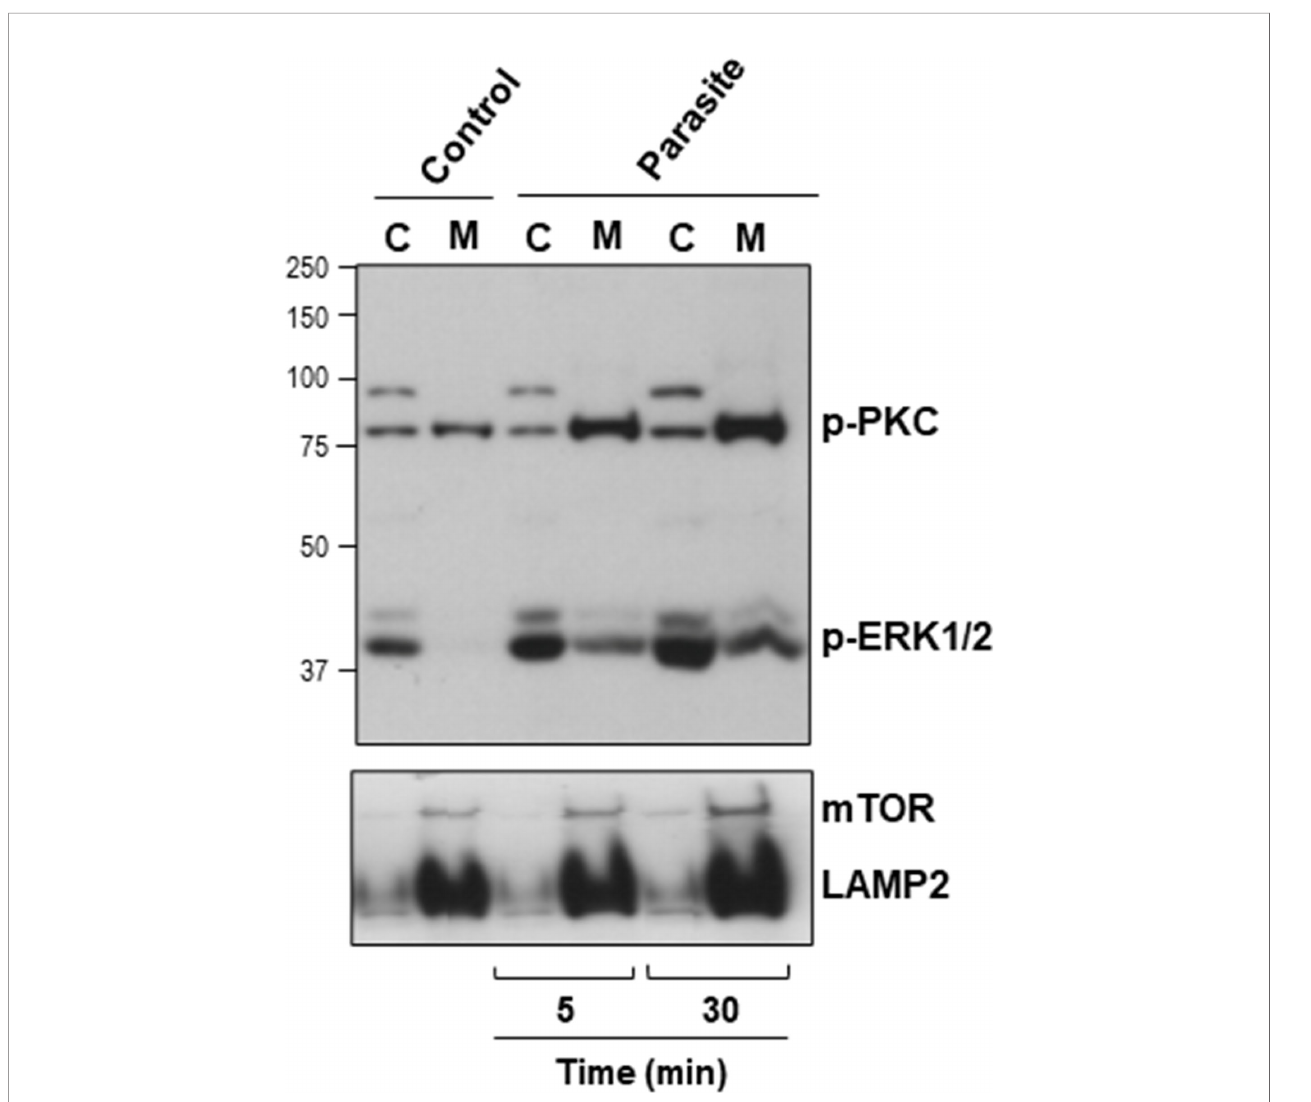
FIGURE 4 | Activation of host cell PKC and ERK1/2 upon interaction with MT. HeLa cells were incubated in absence or in the presence of MT for the indicated time. Cytosolic (C) and membrane (M) fractions were isolated and analyzed using antibody to phospho-PKC and to phospho-ERK1/2. Anti-LAMP2 and anti-mTOR antibodies were used as fractionation control. Note the increase in the phosphorylation levels of PKC and ERK1/2 induced by